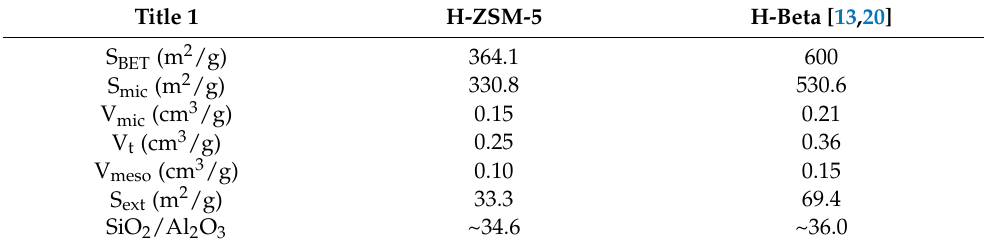
Figure 1. XRD pattern ( A ), N 2 adsorption–desorption isotherm ( B ) and SEM images with different magnifications ( C , D ) of the prepared zeolite H-ZSM-5. Table 1. The properties of the prepared zeolite H-ZSM-5 and